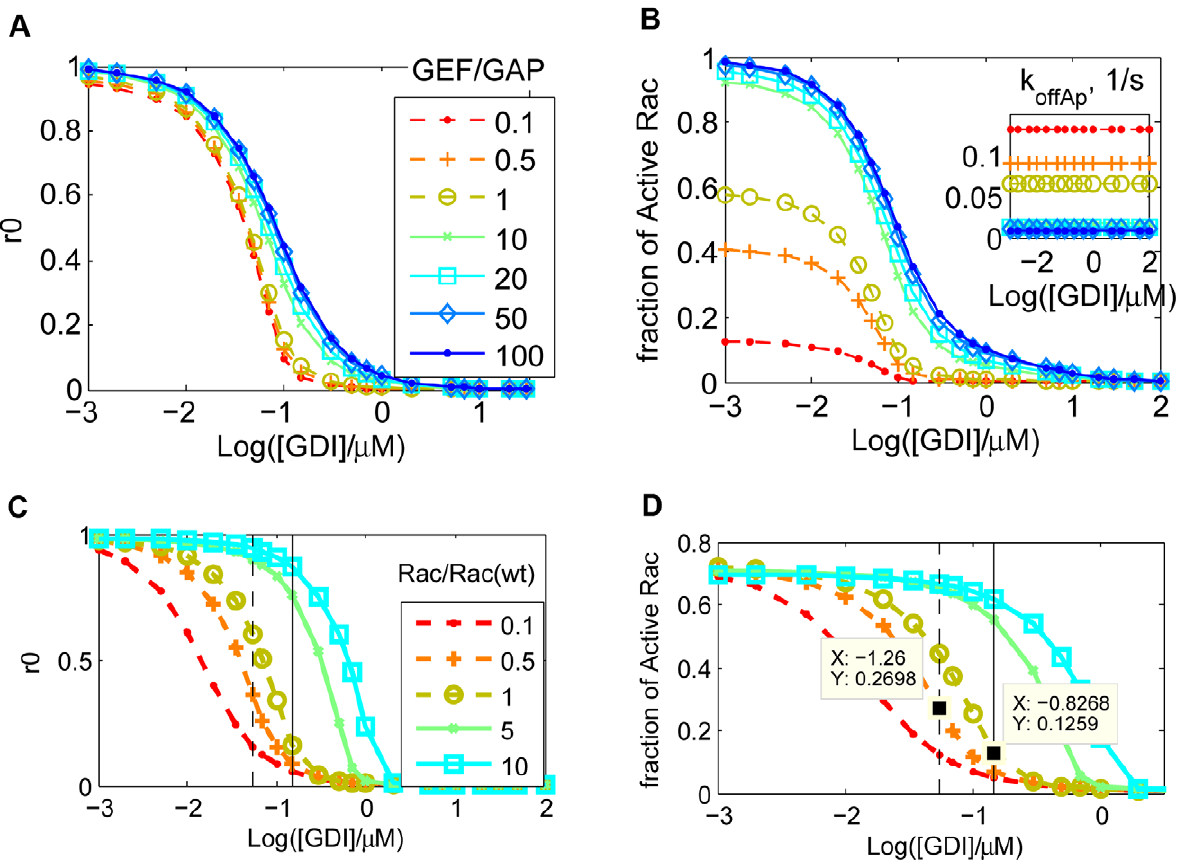
Figure 4. Dependence of fraction of GTPase at the membrane r0, membrane dissociation rate k offAp , and fraction of active Rac on GDI concentration. A–B. effect of GEF/GAP ratio. C–D. Effect of Rac concentration, relative to experimental condition ‘wt’. Vertical lines: GDI concentration for ‘wt’ (solid), and for ‘wt 2 GDI’ (dashed). While the fraction of active Rac doubled for ‘wt 2 GDI’, the total amount of active Rac is the same when Rac concentration is decreased by half (curve with crosses relative to open